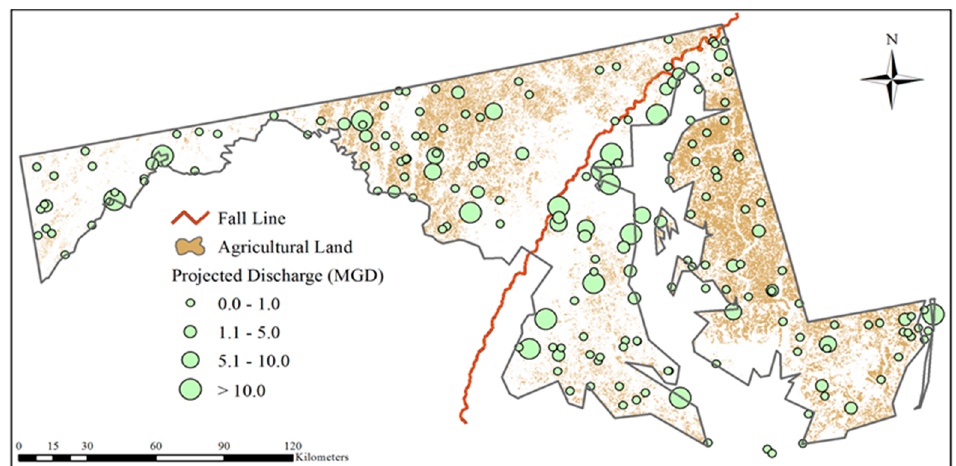
Figure 4. Location of all selected wastewater treatment plants (WWTPs) within Maryland.